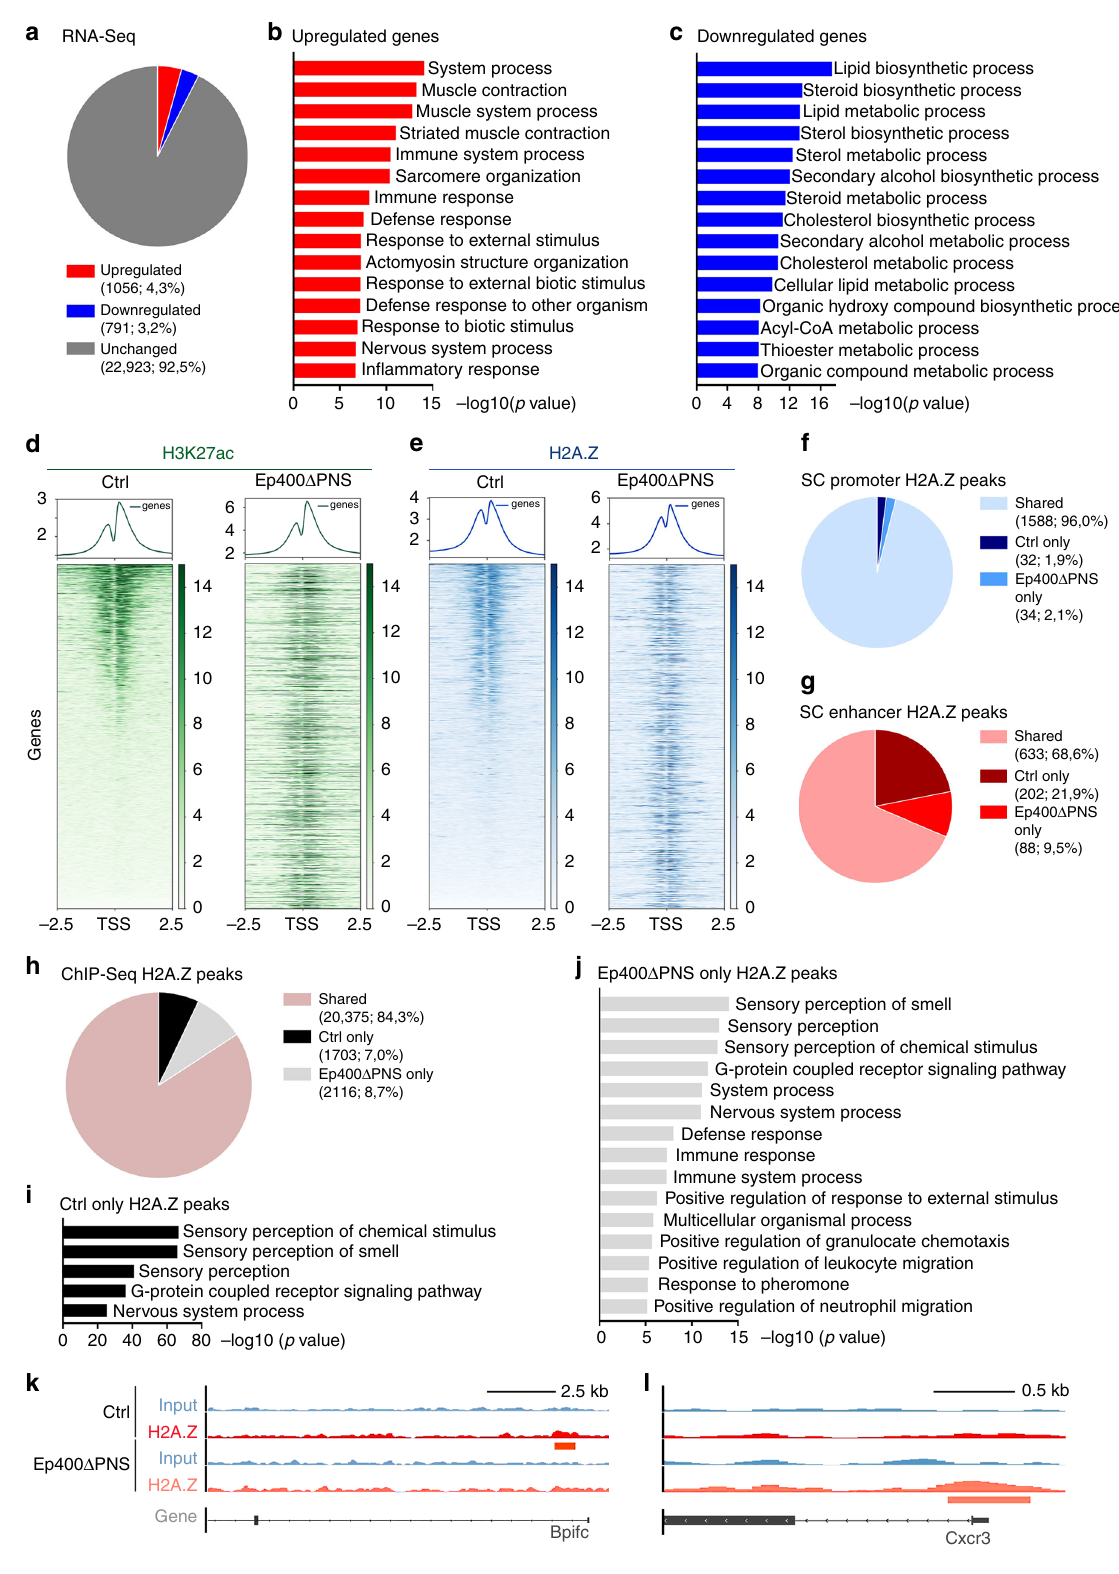
control samples (Fig. 3e), H2A.Z was also substantially ChIP-Seq was also performed with H2A.Z-speci fi c antibodies redistributed in the mutant. (Fig. 3e, for PCA and model-based analysis (MA) blots, see Among the upregulated genes in Ep400 Δ PNS nerves that had Supplementary Fig. 7b, c). Like the H3K27ac modi fi cation, the gained H2A.Z in their promoter, 37% had also gained H3K27ac, H2A.Z isoform was enriched around the TSS. As evident from whereas 52% were already H3K27ac-positive before. Another 11% heatmaps of control and Ep400 Δ PNS mice in which genes were had gained H2A.Z in their promoter but remained negative for ordered according to H2A.Z enrichment around the TSS in NATURE COMMUNICATIONS| (2019) 10:2361